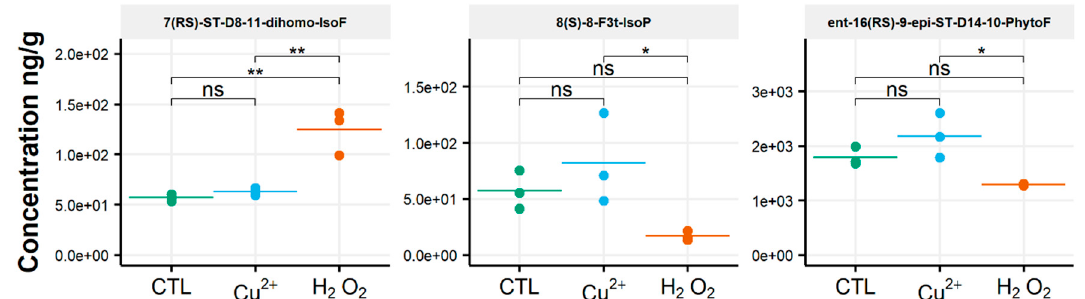
Figure 3. Changes in contents of selected isoprostanoids for the cryptophyte Rhodomonas salina between the control condition (CTL) and oxidative stress (Cu 2 + and H 2 O 2 ) conditions. Statistically relevant responses between the control and stress conditions (one-way ANOVA) are indicated by asterisks: * p < 5 × 10 − 2 and ** p < 5 × 10 − 3 ; ns, not significant.